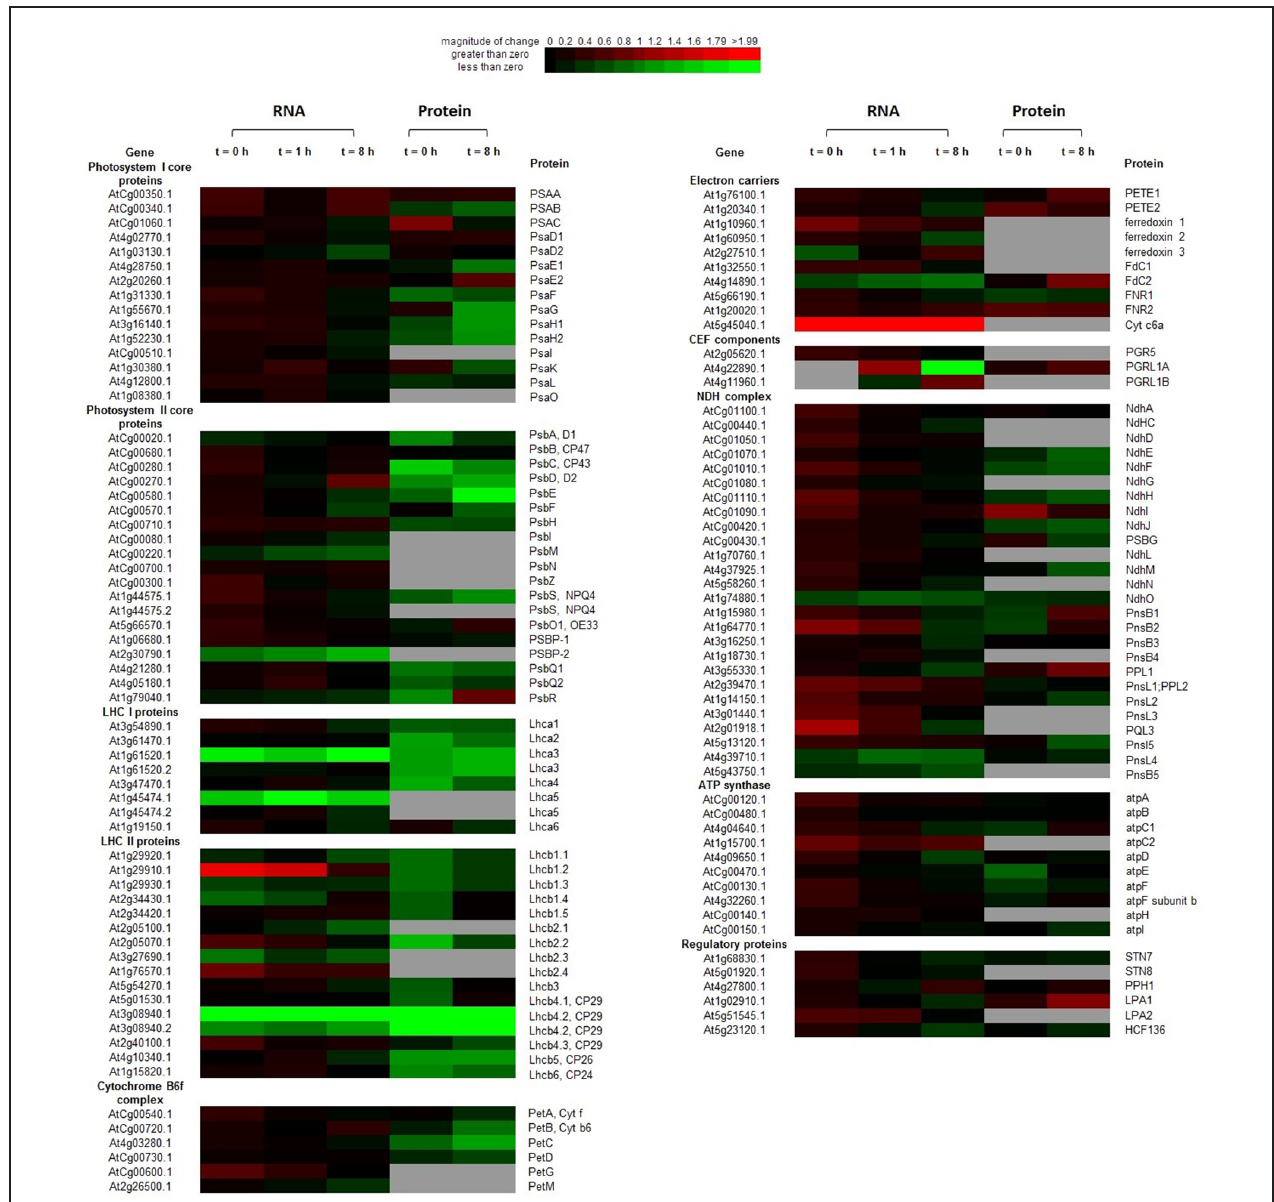
FIGURE 4 | Heatmap of transcription and translation profiles of photosystem compared WT with OE in 20-days-old leaves of Arabidopsis . Each value was calculated by log 2 ratio and colors were scaled per row with up-regulated in red and down-regulated in green. The gray ones indicated the missing data in RNA-Seq or iTRAQ. Heatmap was generated from http://bbc.botany.utoronto.ca/ntools/cgi-bin/ntools_heatmapper_plus.cgi.